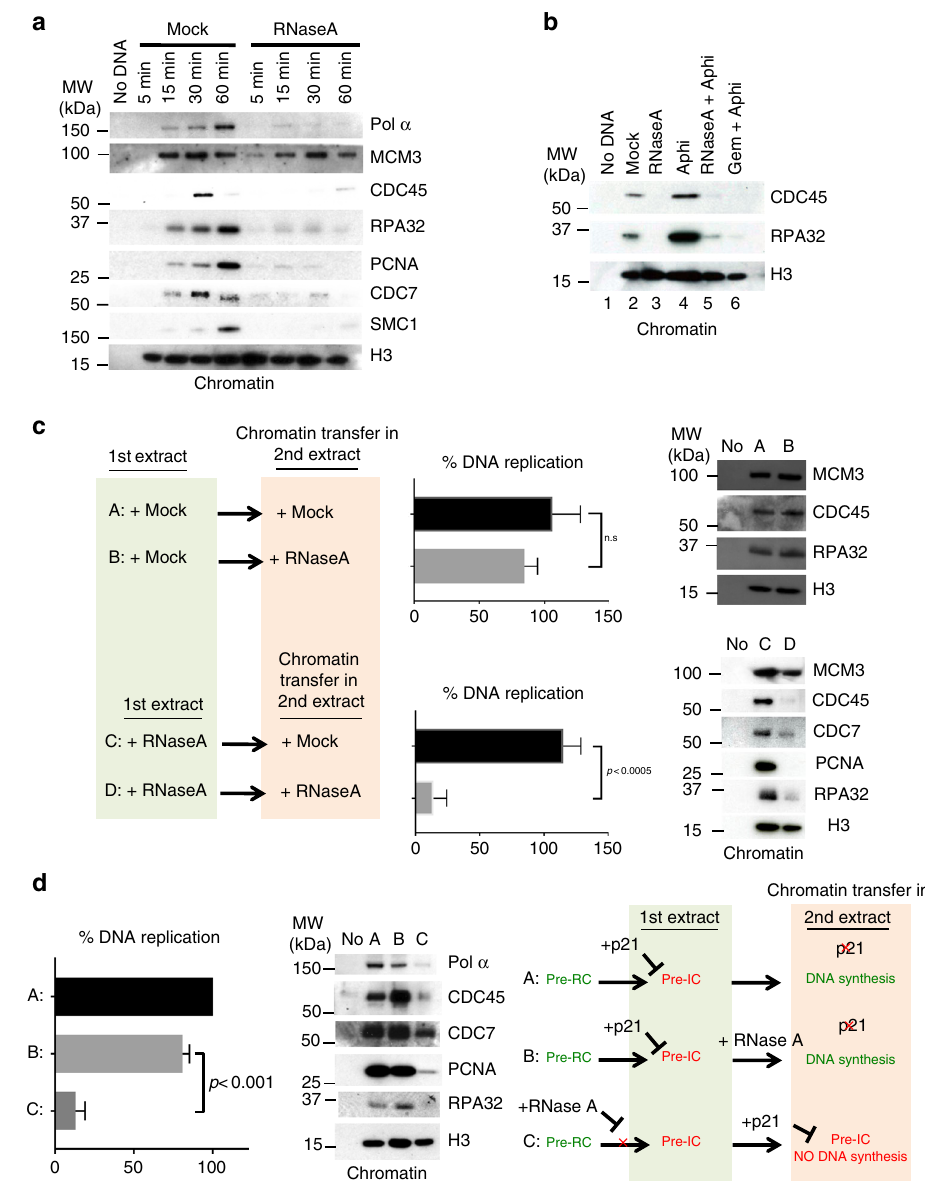
Fig. 3 RNA is required for pre-IC assembly but is dispensable after pre-IC formation. a Time-course analysis of the recruitment of pre-IC and replication fork components to sperm chromatin in mock- and RNase A-treated LSEs. Histone H3 was used as a loading control. b Western blot showing the absence of DNA unwinding in RNase A-treated extracts. Sperm chromatin was puri fi ed and analysed 30 min after incubation in LSE. Incubation with 100 ng/ μ l aphidicolin (Aphi) resulted in RPA overloading following DNA polymerase inhibition and uncoupling from the MCM2-7 helicase activity. Geminin was used as negative control. c Chromatin transfer experiments showing that DNA replication is inhibited by RNA depletion before pre-IC formation in a reversible manner. Lanes A and B, chromatin was assembled in a mock-treated LSE for 40 min to allow pre-IC formation, and then transferred to an RNase A-treated extract or another mock extract (control). The graph shows the percentage of DNA replication at 120 min after chromatin transfer ( n = 5), and the right panel shows the loading of replication proteins onto chromatin. Lanes C and D, the DNA replication defect is abolished when nuclei assembled in RNase A- treated extracts are transferred into mock-treated extracts C, but not after transfer into a new RNAse A-treated extract D. Error bar represents the standard deviation (SD). P -values were determined with the two-tailed Student ’ s t -test. n.s.: not signi fi cant. d RNA depletion blocks S-phase-dependent kinase activation. Lanes A and B, sperm nuclei were initially incubated in p21-treated LSE (for 30 min) and then transferred to mock- or RNase A-treated LSE, respectively. C: Chromatin assembled in an RNase A-treated LSE extract was transferred in a p21-treated extract. DNA replication levels ( n = 3) and binding of replication factors to chromatin were monitored as described in a . Error bar shows the SD. A two-tailed Student ’ s t -test was performed to calculate the p -values RNAs mediate NPC assembly in an ELYS-dependent manner . a mock-treated extract, which contains the nuclear membrane fraction, rescued DNA replication (Fig. 4c, lane D). Nuclear import is mainly governed by a subset of proteins called Together, these results show that RNAs are required for the NUPs that form NPCs. Analysis of NPC assembly by immuno- fl uorescence staining and western blotting using a mouse formation of a functional NE that can concentrate nuclear factors monoclonal antibody (mAb414) against several NUPs (NUPs involved in DNA replication activation. NATURE COMMUNICATIONS | 8:2130 | DOI: 10.1038/s41467-017-02180-1 |